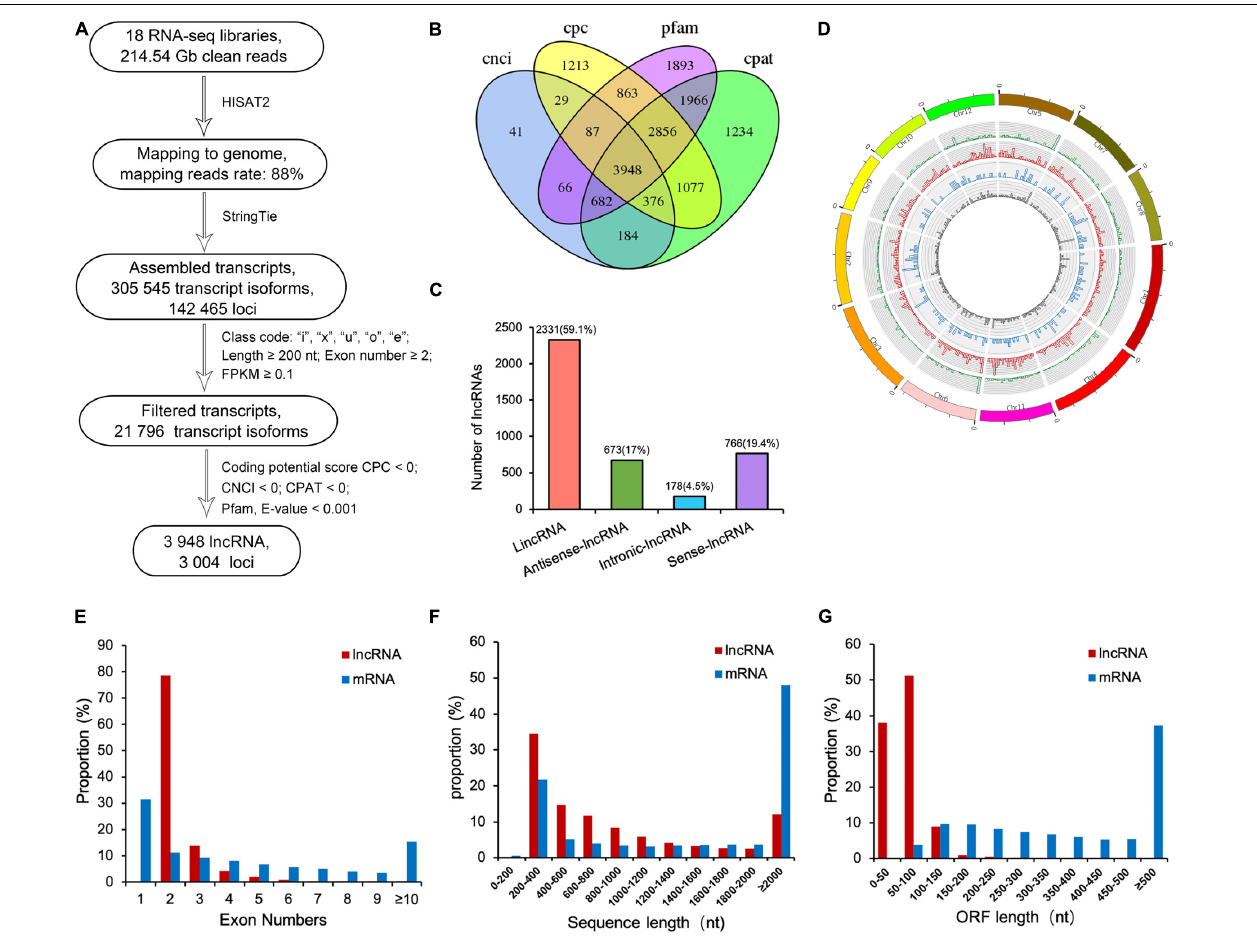
FIGURE 1 | Computational pipeline for systematically identifying of lncRNAs in the PTGMS rice line WXS and their characteristics. (A) An integrative computational pipeline for the systematic identification of lncRNAs in WXS rice. (B) Venn diagram showing the numbers of potential lncRNAs filtered by four methods, including Pfam, CPC, CPAT, and CNCI. (C) Classification of identified lncRNAs. (D) Distribution of different types of lncRNAs. The concentric rings from outer to inner represent sense-lncRNAs (green), lincRNAs (red), antisense-lncRNAs (blue), and intronic-lncRNAs (gray), respectively, according to the loci of lncRNAs along each chromosome. (E) Distribution of exon numbers of lncRNAs and mRNAs. (F) Length distribution of lncRNAs and mRNAs. (G) Distribution of the open reading frame (ORF) lengths of lncRNAs and